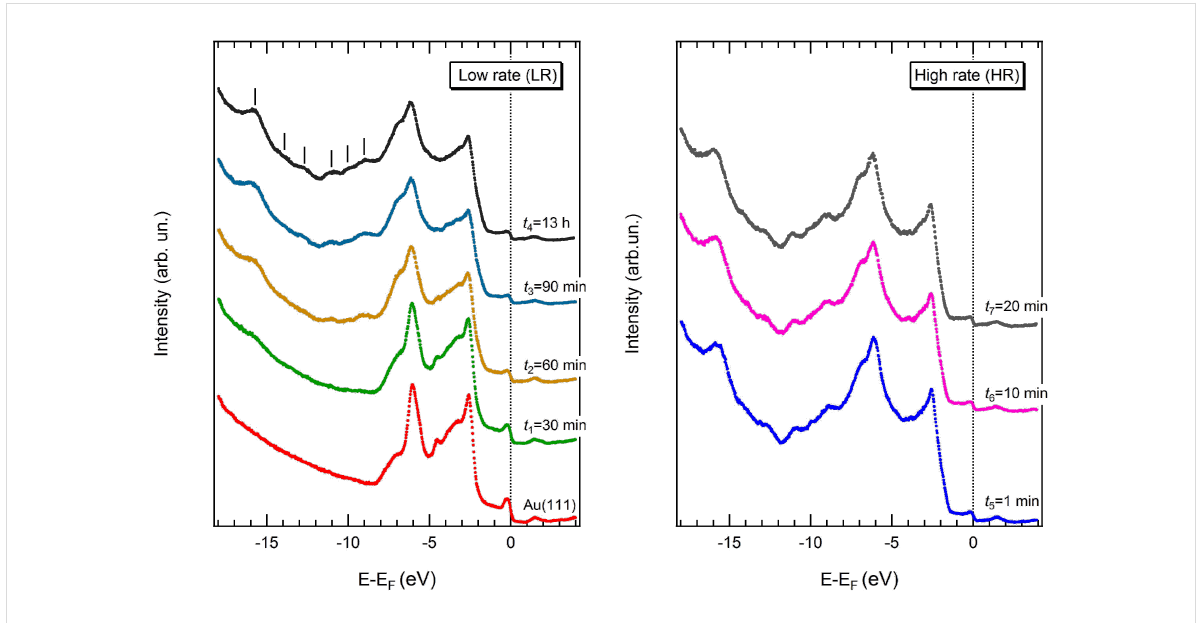
Figure 1: UPS spectra acquired for the Au(111) sample exposed to increasing doses of Fe(dpm) 3 with low (left) and high (right) deposition